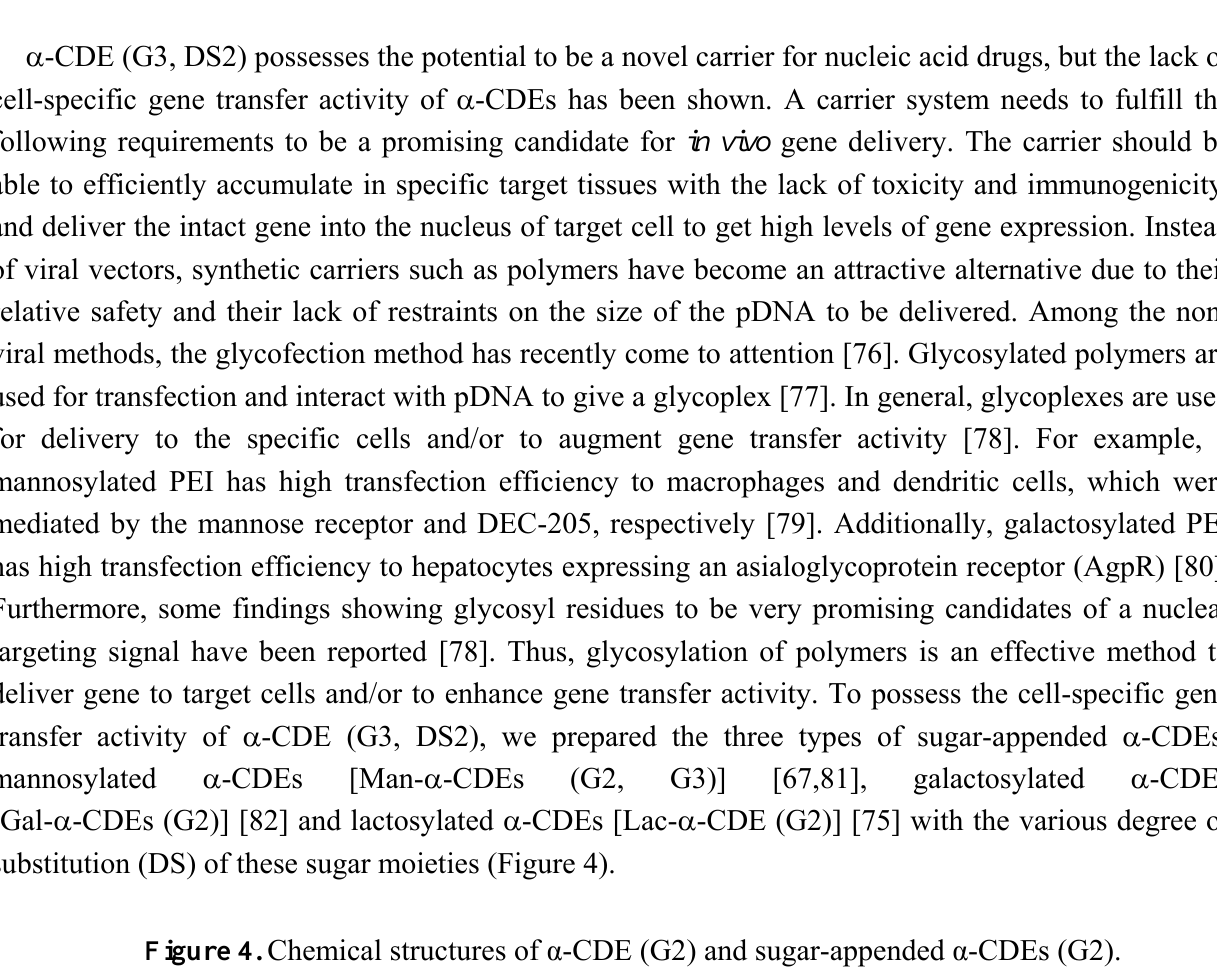
Figure 4. Chemical structures of α -CDE (G2) and sugar-appended α -CDEs